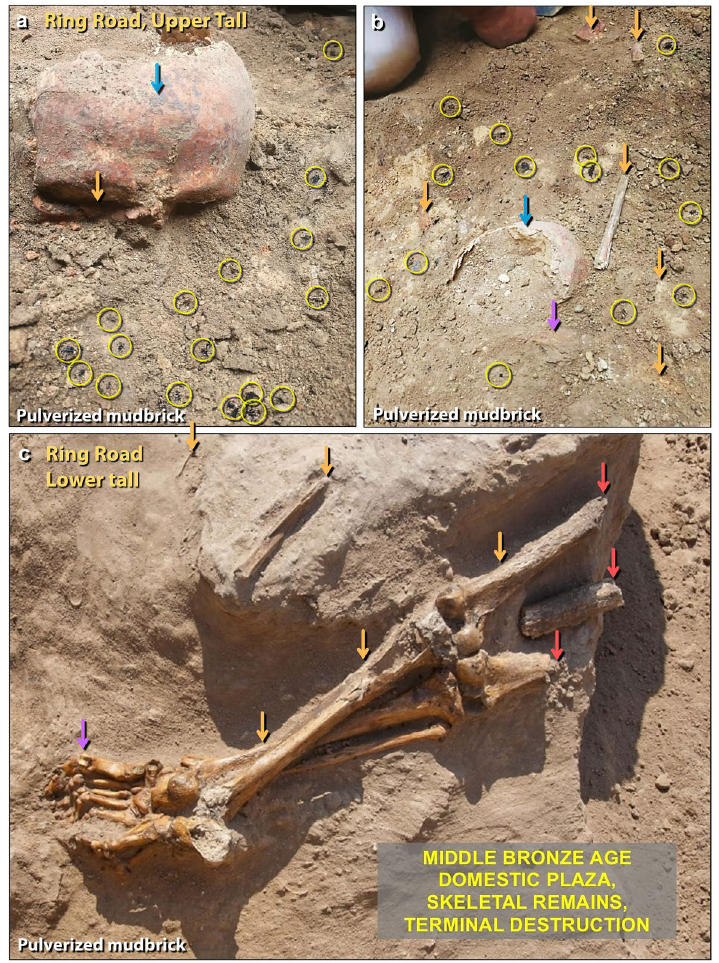
Figure 44. Human bones in the destruction layer. ( a ) Photo of a disarticulated skull found near the palace on the ring road around the upper tall. The right eye socket has been crushed (orange arrow). Skull is embedded in pulverized mudbrick containing numerous charcoal fragments (yellow circles) and is stained with ash commonly found in the destruction layer (blue arrow). The orange tint of the skull suggests it was exposed to temperatures > 200 °C 141 . ( b ) Rear view of the same skull in panel ‘ a ’ (blue arrow) near the second skull (purple arrow) and numerous disarticulated, fragmented human bones (orange arrows). Charcoal fragments at yellow circles. ( c ) Lower torso from the ring road of lower tall (orange arrows), and other disarticulated bones. Bones show evidence of being burned (red arrows); the rest of the skeleton is dismembered and disarticulated. Hyper- flexed toes (purple arrow) are consistent with either perimortem or postmortem exposure to high